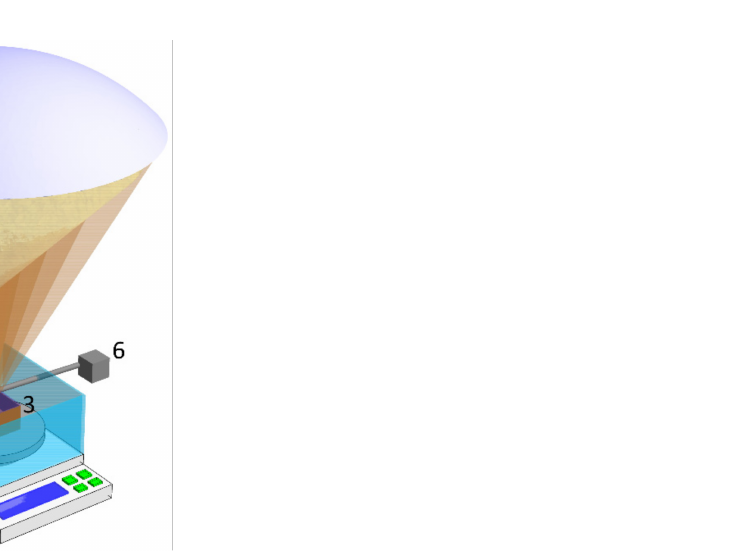
Figure 1. Scheme of the experimental setup for high-temperature gasification of the fuel under a light flow. It includes a light source (1), a parabolic mirror for light focusing (2) and a cuvette with fuel (3) placed on an electronic balance (4) platform. The gas analyzer (6) is connected to the cuvette with a quick connect fitting. The thermal imaging system is (5).